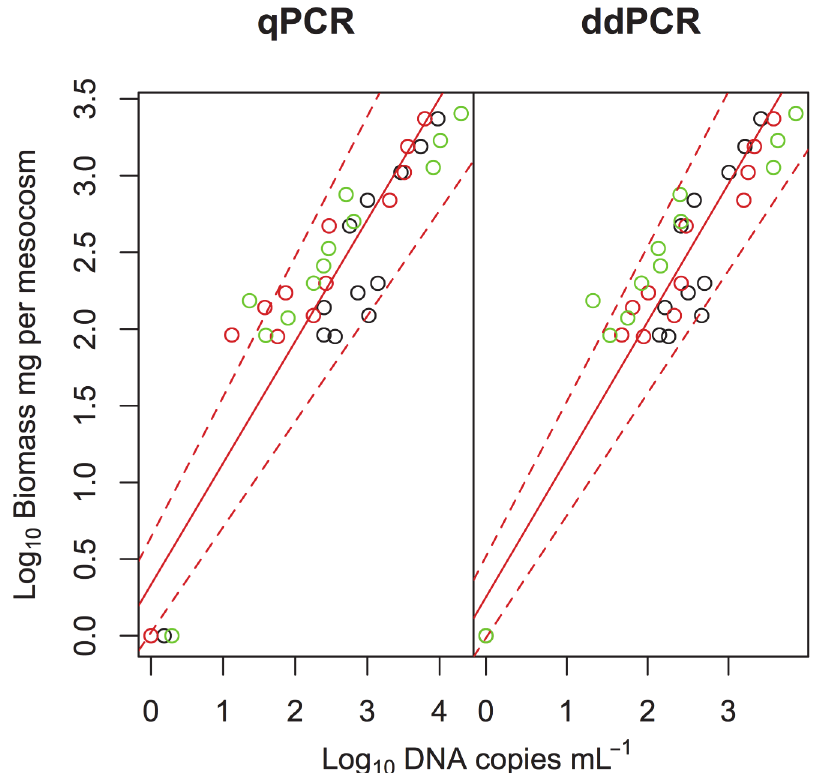
Fig 4. Relationships between eDNA concentrations of common carp and their biomass in the mesocosm experiment. Black, red, and green symbols indicate samples collected on days 1, 2, and 3, respectively. Solid red and dashed red lines indicate Type II regression and 95% CI,